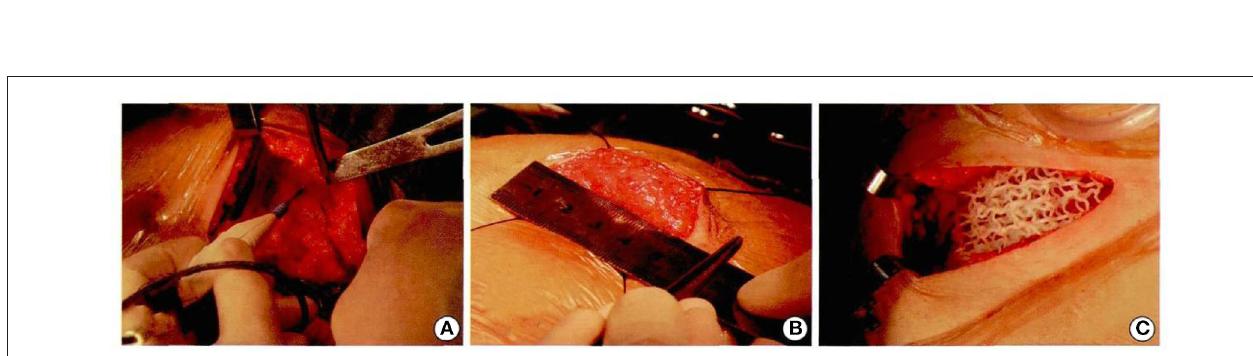
FIGURE 8 | Patients underwent computer-assisted 3D printing of degradable materials for breast reconstruction (A–C) .